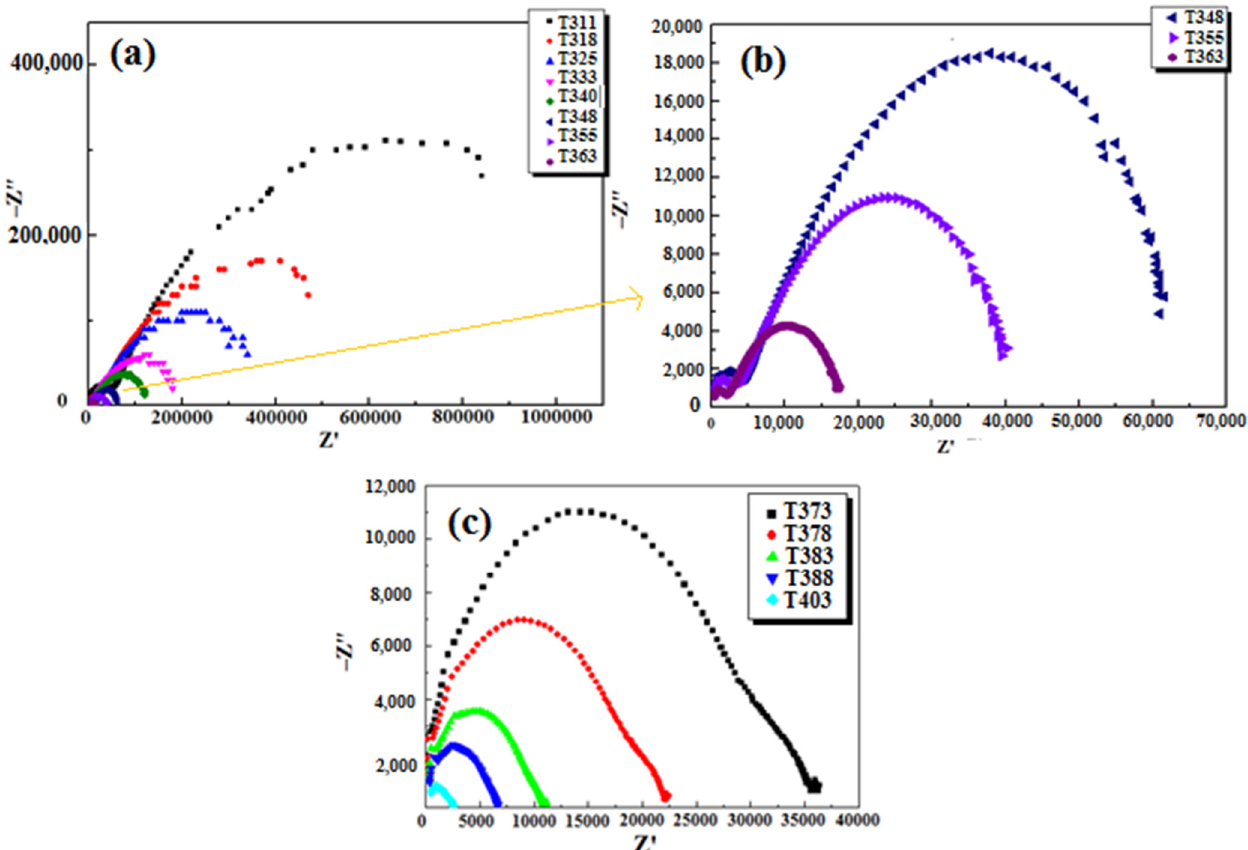
Figure 13. ( a )-–Z ″ versus Z’ of (C 5 H 14 N 2 )[HgCl 4 ]·H 2 O at the range of 311–363 K; ( b ) Illustrative rep- Figure 13. ( a )—Z (cid:48)(cid:48) versus Z (cid:48) of (C 5 H 14 N 2 )[HgCl 4 ] · H 2 O at the range of 311–363 K; ( b ) Illustrative resentation of –Z ″ versus Z’ of (C 5 H 14 N 2 )[HgCl 4 ]·H 2 O at 363, 355 and 348 K; ( c )—Z ″ versus Z’ of representation of –Z (cid:48)(cid:48) versus Z (cid:48) of (C 5 H 14 N 2 )[HgCl 4 ] · H 2 O at 363, 355 and 348 K; ( c )—Z (cid:48)(cid:48) versus Z (cid:48) of (C 5 H 14 N 2 )[HgCl 4 ]·H 2 O at the range of 373–403 K. (C 5 H 14 N 2 )[HgCl 4 ] · H 2 O at the range of 373–403